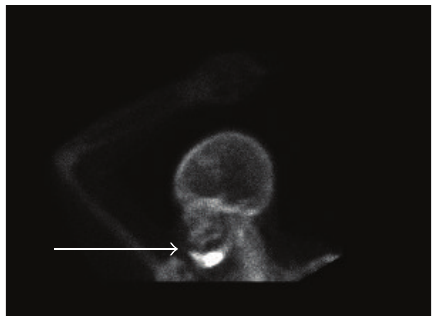
Figure 2: Technetium 99m Bone scintigraphy. Bone scan showing increased radioactive uptake in the body of the mandible (arrow) thought to be metastatic disease.